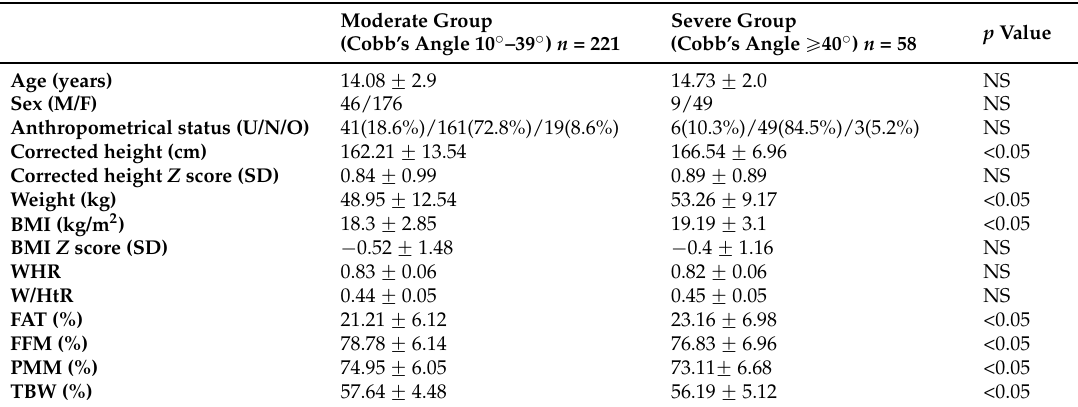
Table 1. Characteristics and comparison of the anthropometric measurements among the moderate and severe groups in total studied idiopathic scoliosis (IS) population.